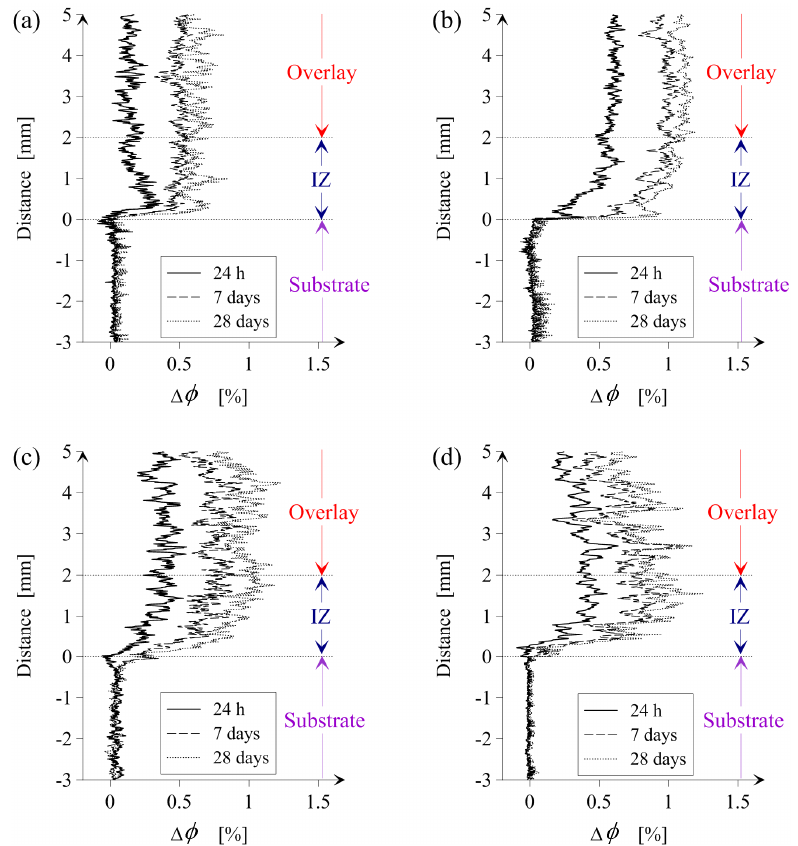
Figure 8. The change in microporosity φ as a function along a sample height obtained within the IZ between the overlay made of cement mortar and the existing concrete substrate obtained using the micro-CT method at different moments of hardening of the overlay for Samples ( a ) T1; ( b ) T2; ( c ) T3; and ( d ) T4.